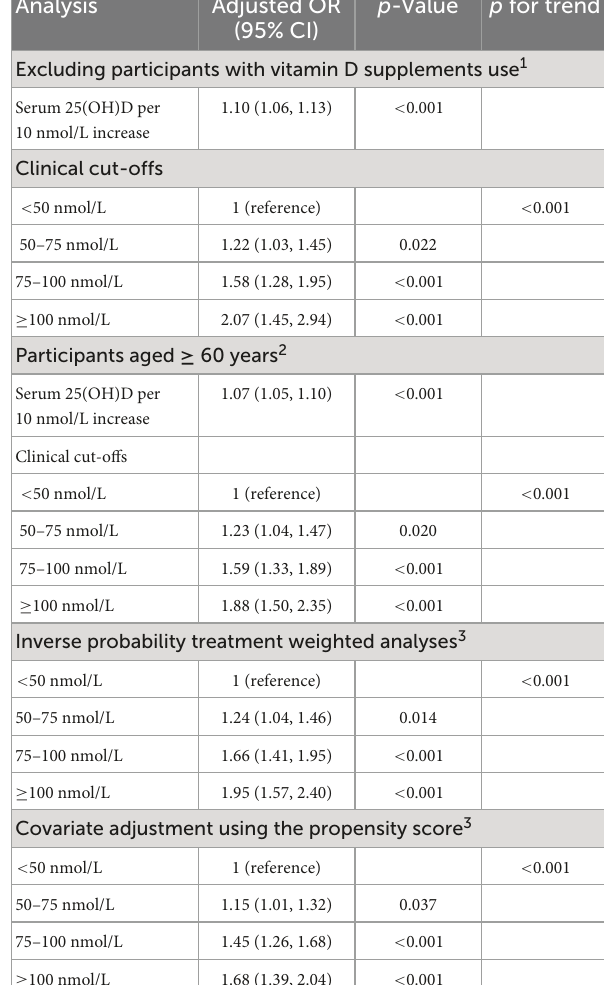
TABLE 4 Sensitivity